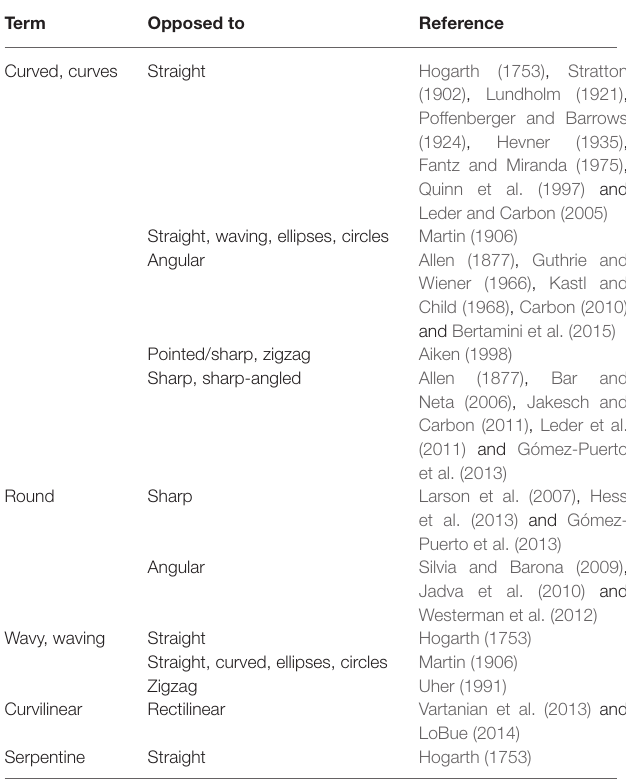
TABLE 1 | Terminology used throughout relevant literature on curvature